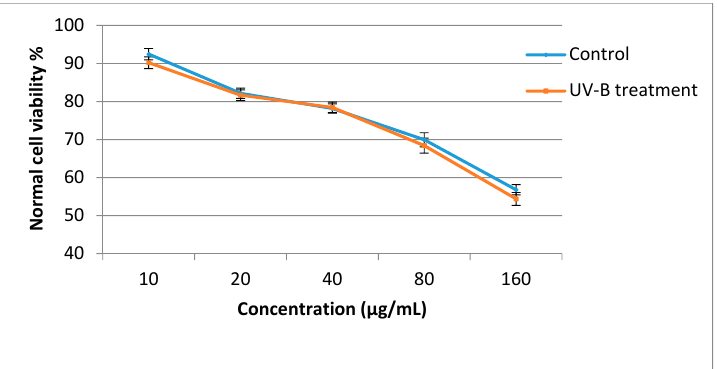
Figure 4. Effect of sweet basil non-treated leaves and UV-B treated (3.60 W/m 2 , 8-h) leaves against normal cell (MCF-10A) viability. Bars represent standard errors of the means.